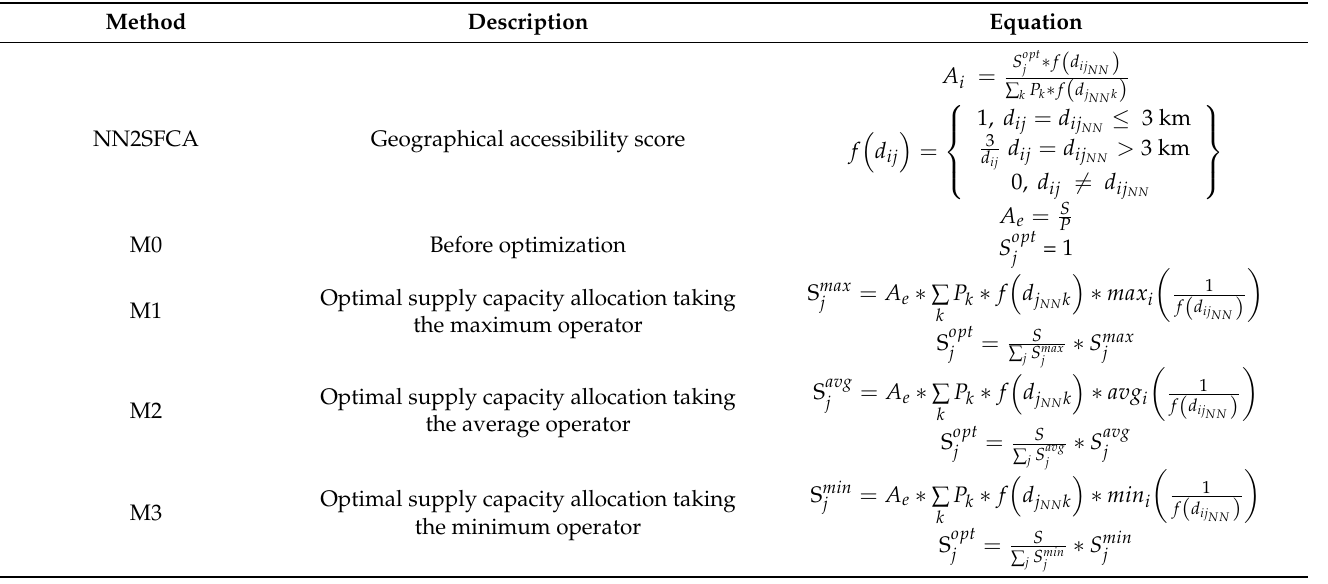
Table 1. Definition of geographical accessibility calculation